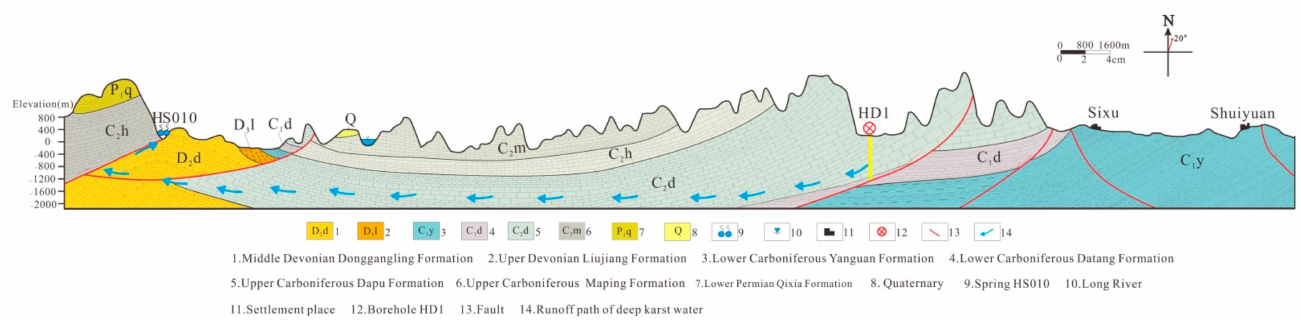
Figure 10. Sectional view of actual geological map of deep karst in Huanjiang syncline. (The deep karst groundwater of HD1 well in the northern part of the syncline recharge the karst spring HS010 in the southern part of the syncline through the fracture